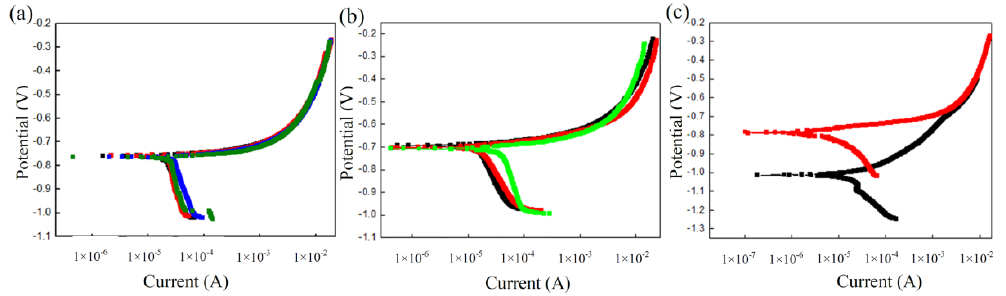
Figure 9. The interface polarization curve of three kinds of joints shown as: ( a ) explosion welding sample, ( b ) cold pressure welding sample and ( c ) solid-liquid casting sample. Table 3. The corrosion potential and the corrosion current density in Figure 9.